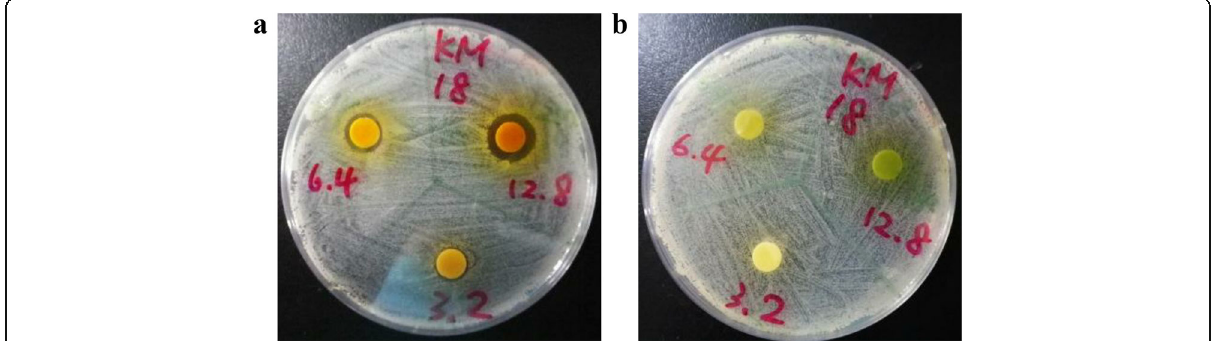
Fig. 1 The antibacterial effect of S. barbata extract ( a ) and L. japonica extract ( b ) assayed at concentrations of 3.2 mg/mL, 6.4 mg/mL and 12.8 mg/mL against A. baumannii strain